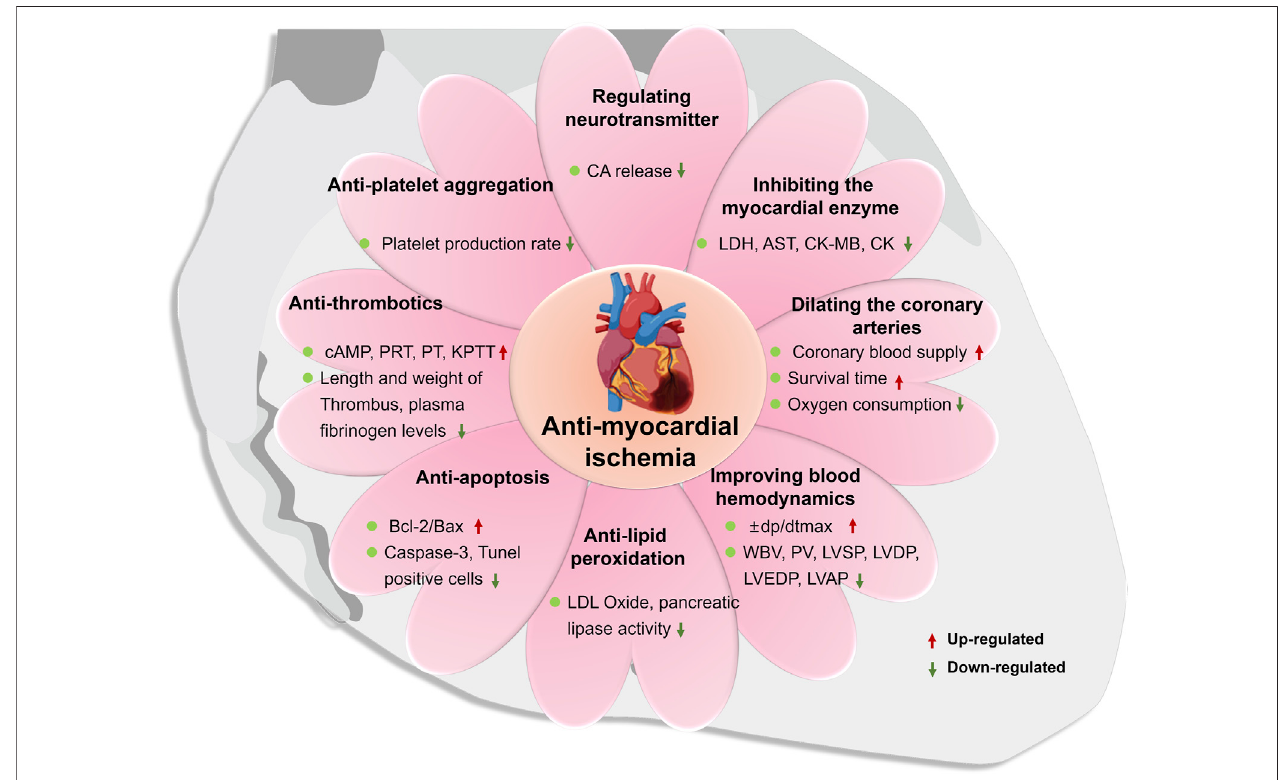
FIGURE 6 | The main pharmacological mechanism of storax on myocardial ischemia.